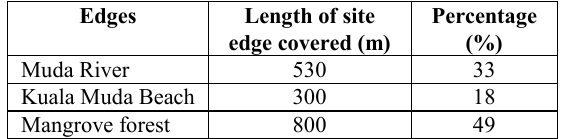
Table 2. Edge data